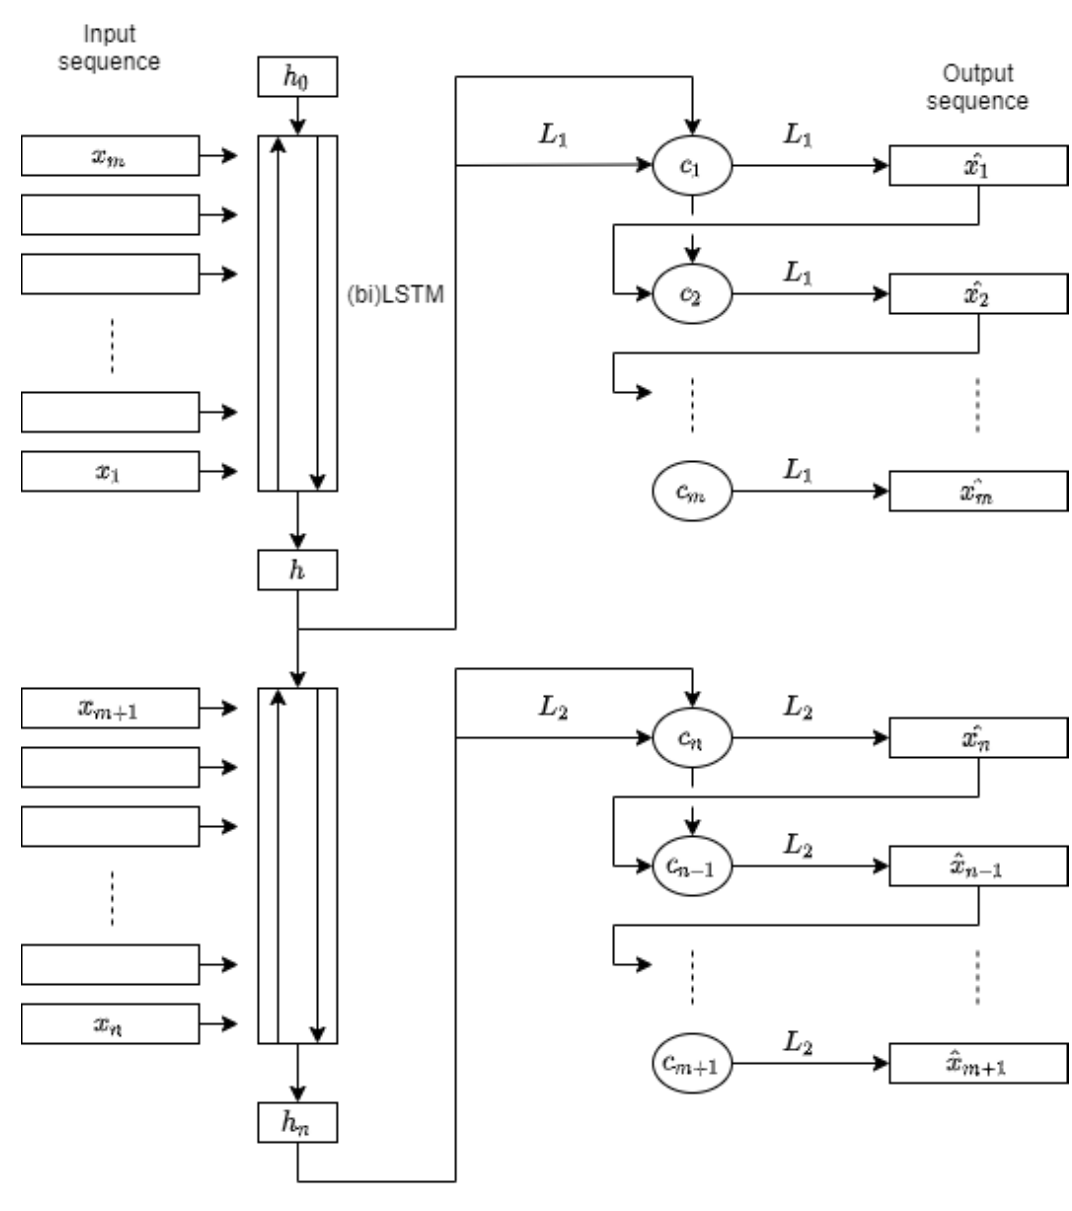
Figure 5. LSTM autoencoder